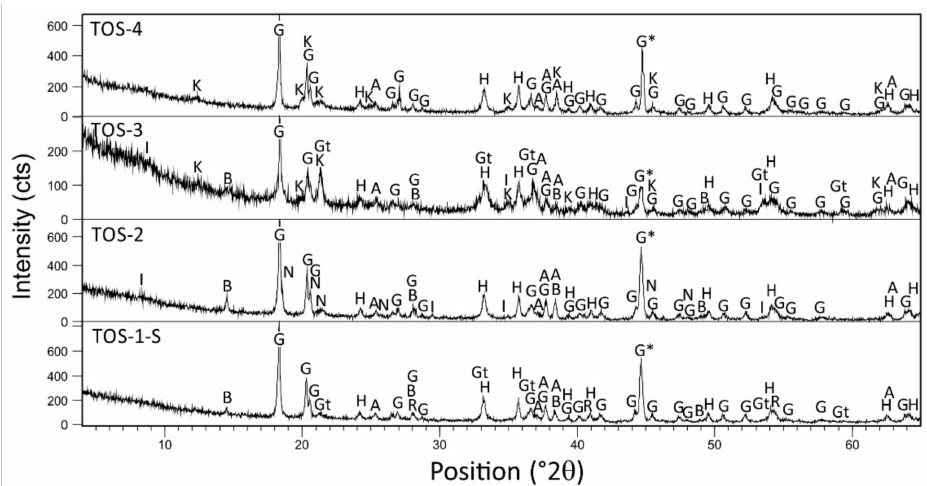
Figure 3. Representative XRD patterns for the samples TOS-1-S, TOS-2, TOS-3, and TOS-4 (G–gibbsite, B–böhmite, N–nordstrandite, H–hematite, Gt–goethite, A–anatase, R–rutile, K–kaolinite, I–illite; * diffraction line of Al–sample holder).